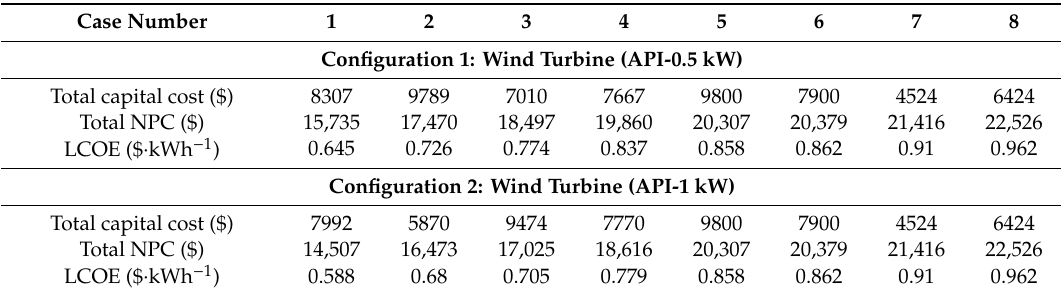
Table 4. Total cost data under two